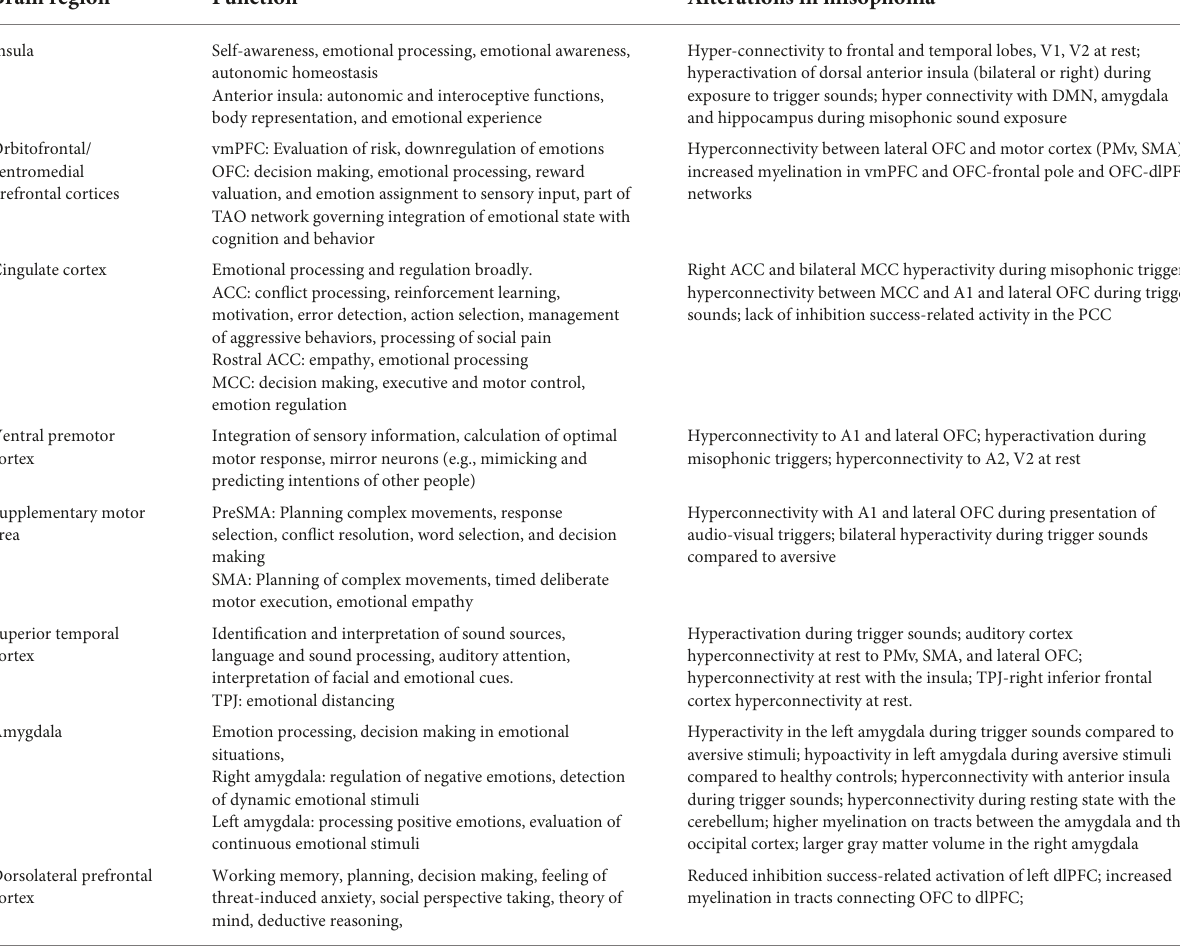
TABLE 1 Summary of brain regions relevant to misophonia, their established function, and the specific alterations in structure and function identified in neuroimaging studies to date. Brain region Function Alterations in